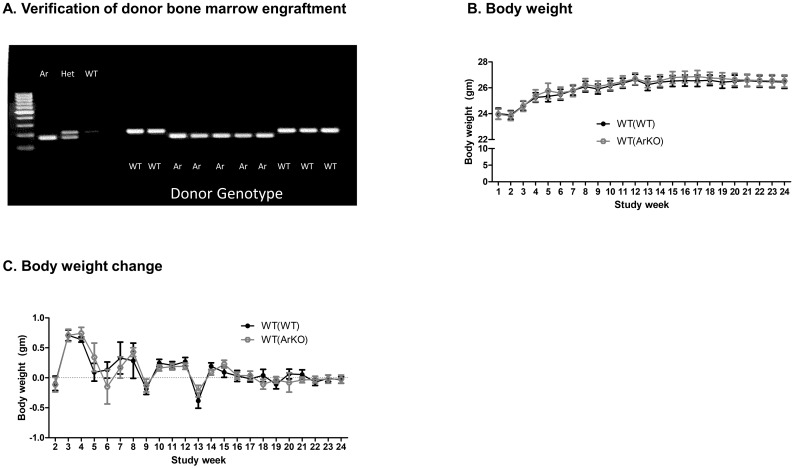
Verification of bone marrow engraftment and body weight in wild-type (WT) male mice transplanted with bone marrow from either WT (WT(WT)) or aromatase-deficient (WT(ArKO) donors.Genotyping of circulating white blood cells was performed to verify successful bone marrow engraftment (A), with illustrative results from 10 animals shown. No differences between groups were found in either absolute body weight (B) or change in body weight (C) over the 24-week study.